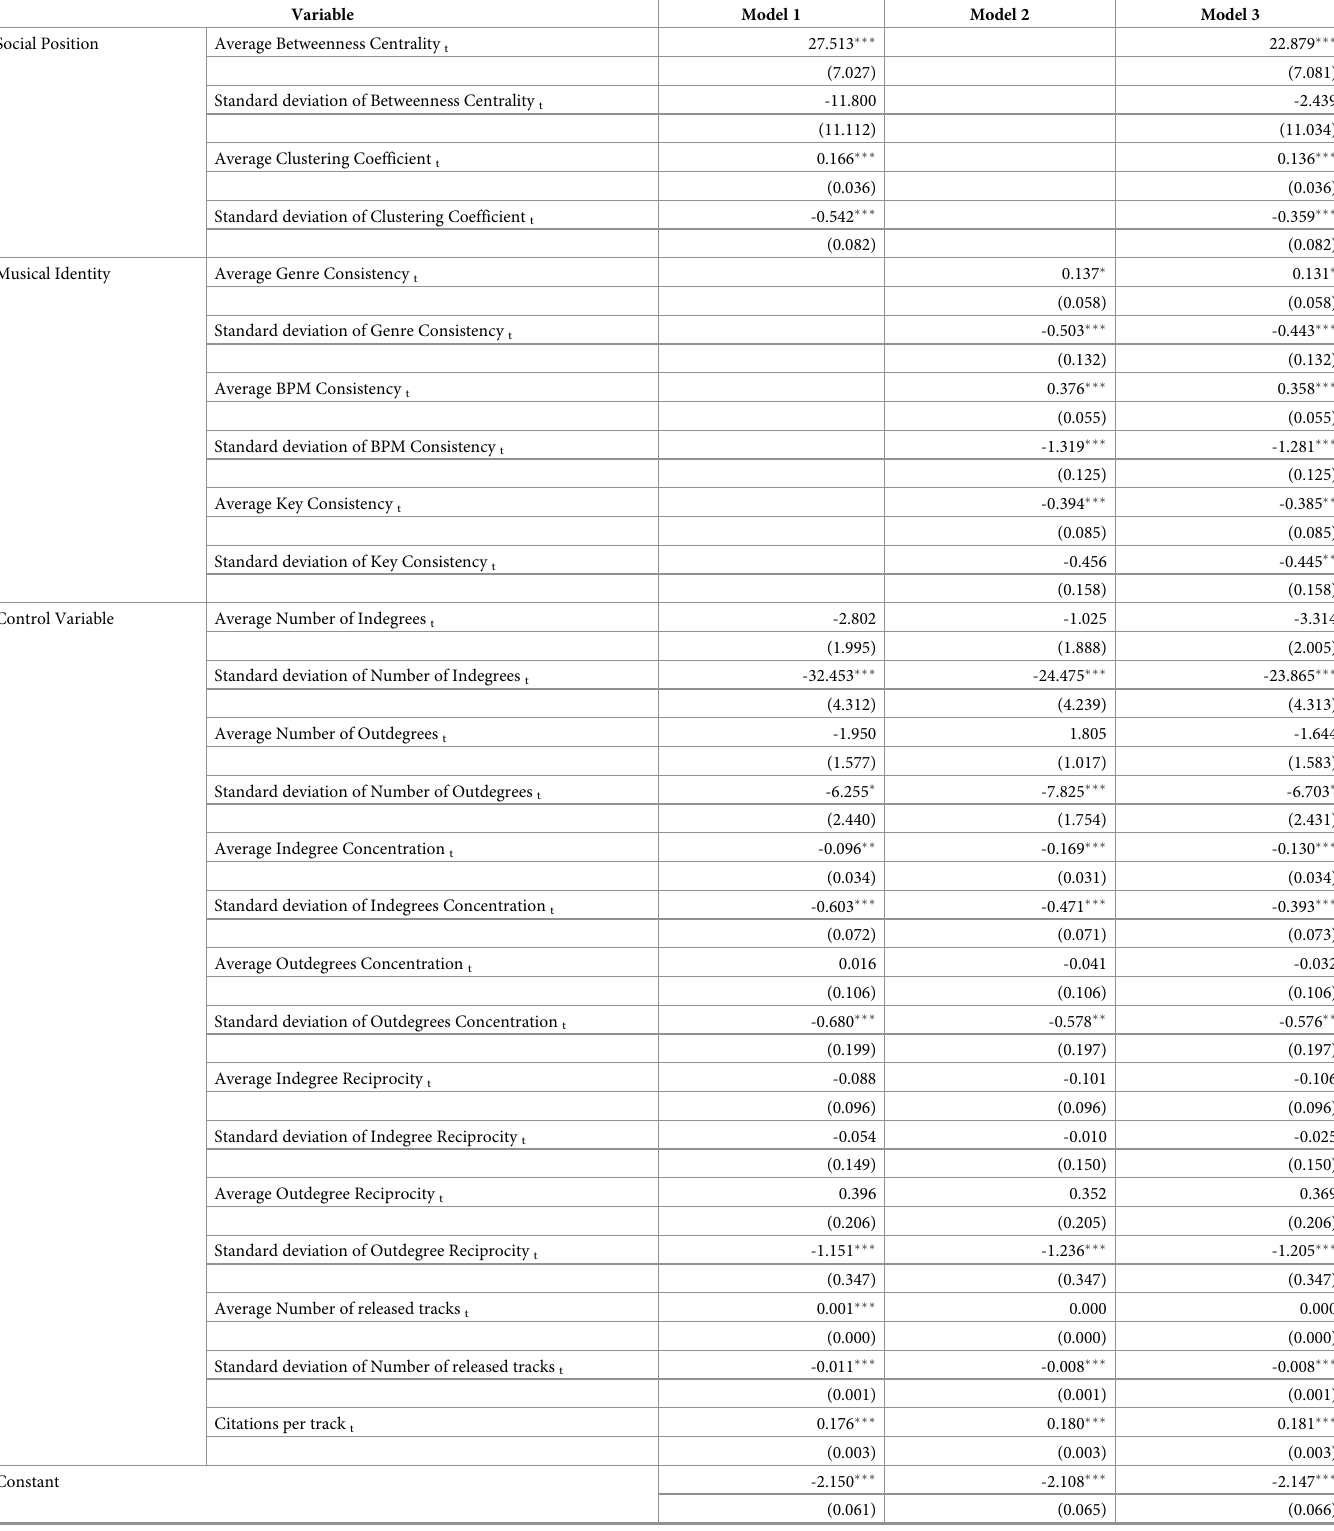
Table 2. Negative binomial regressions predicting the number of citations per track t+1